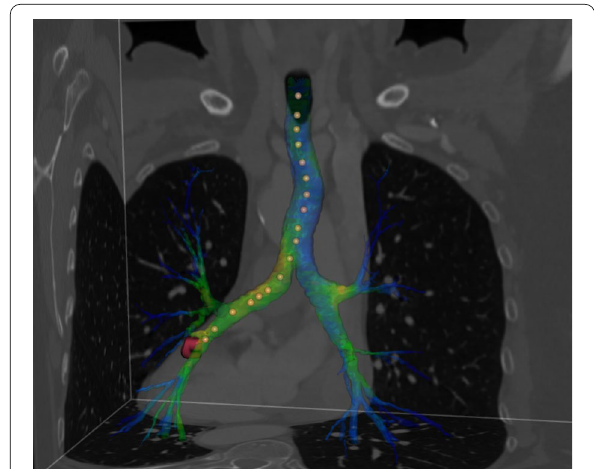
Fig. 2 Parts of the three orthogonal sections of the thorax and the segmented bronchial tree comprising a possible traversal (indicated by dots) in the 3D surface model